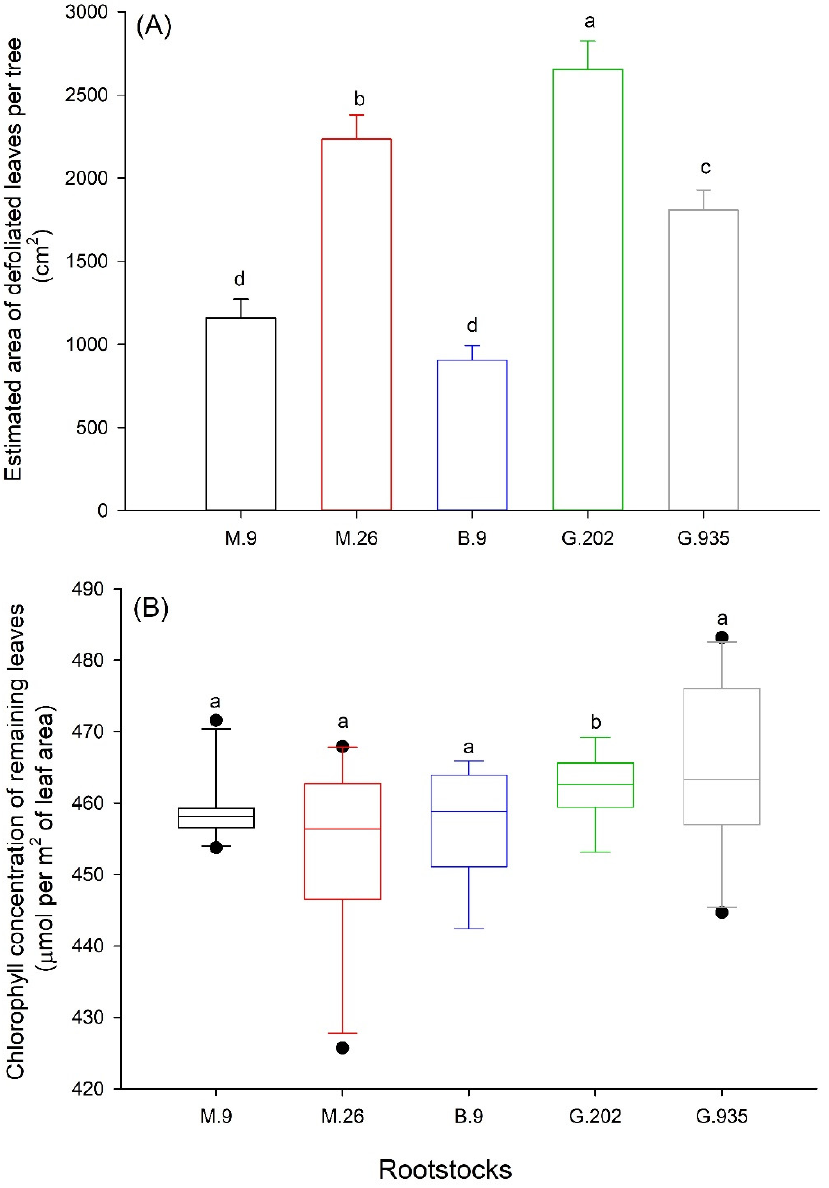
Figure 4. Leaf area of defoliated leaves ( A ) and the chlorophyll concentration of remaining leaves ( B ) of Ambrosia TM apples on five rootstocks by the end of greenhouse water deficit experiment. Different letters in each sub-panel stand for significant difference amongst rootstocks ( P ≤ 0.05, ANOVA, Fisher LSD pairwise comparisons; n = 10).